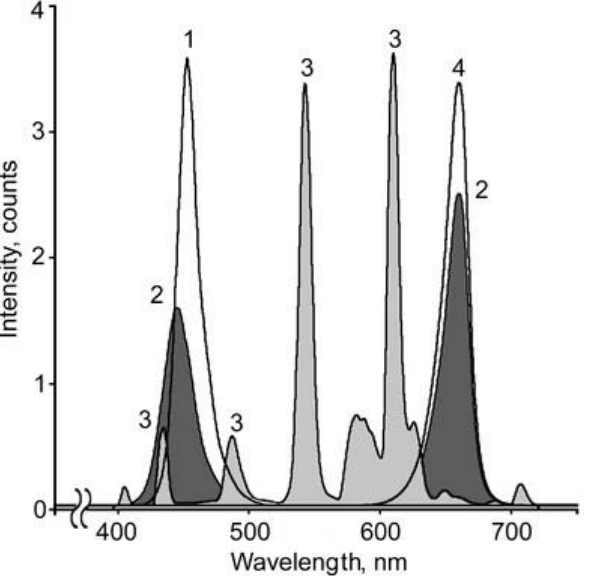
Figure 1. Emission spectra of the light sources used in the experiments. Spectra of blue light (BL) with a peak at 450 nm (1), blue + red (BRL) with two maxima at 445 nm and 660 nm (2), white fluorescent lamps (WFL) with a set of peaks in the visible spectral region (3), and red light (RL) with a peak at 660 nm (4).